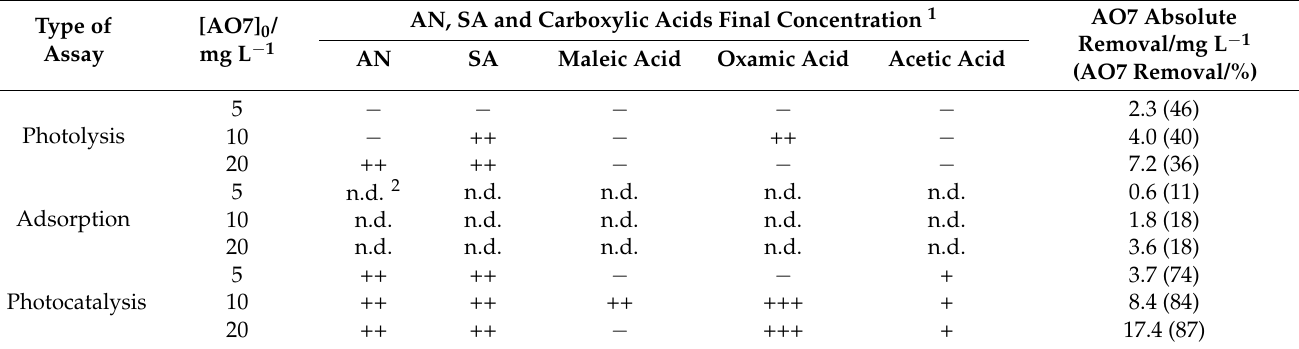
Table 3. Results from photolysis, adsorption, and photocatalysis, with BaFeO 3 _CM_1130 ◦ C_4 h, utilizing sunlight and different AO7 initial concentration: [catalyst] = 0.5 g L − 1 ; Volume = 50 mL; Assay duration—4